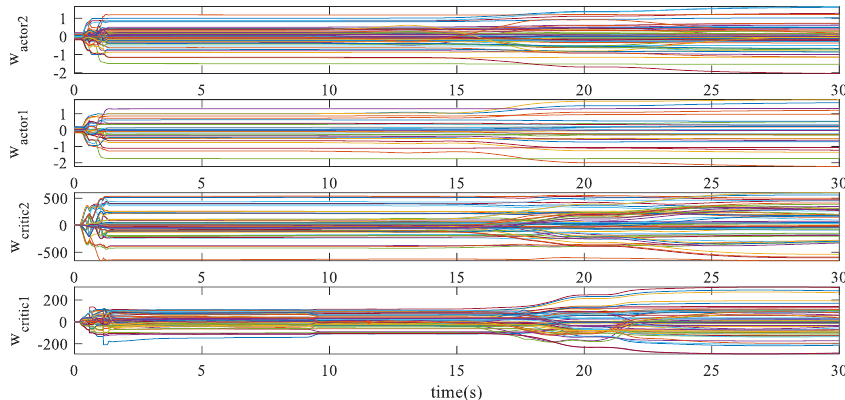
Figure 11. Weights updating of actor NN and critic NN .